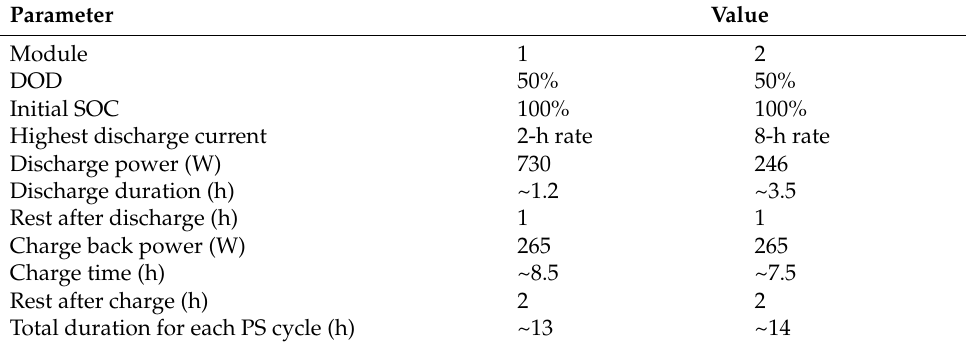
Table 2. Peak Shaving Characteristics.